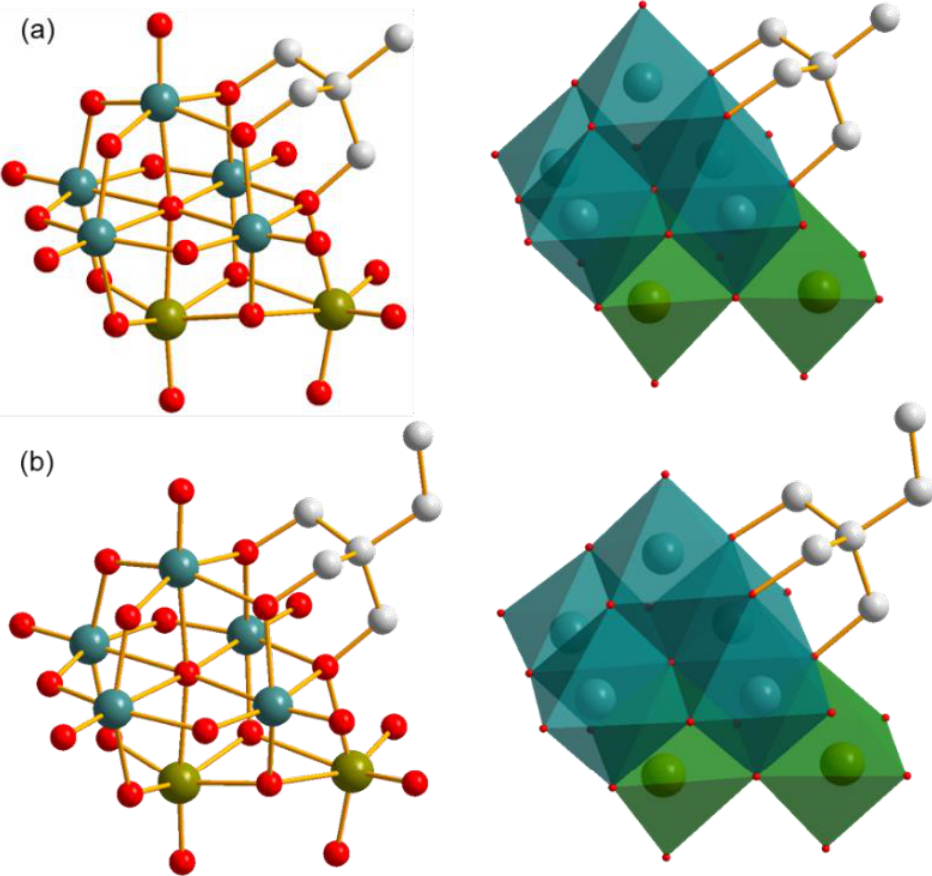
Figure 2. Polyanionic structures of compounds ( a ) 1 and ( b ) 2 in ball-and-stick representation (left) and combined ball-and-stick and polyhedron representation (right). All H atoms are omitted for clarity. Dark cyan ball: V, olive ball: Mo, light grey ball: C, red ball: O, dark cyan polyhedron: {VO 6 }, olive polyhedron: {MoO 6 }.